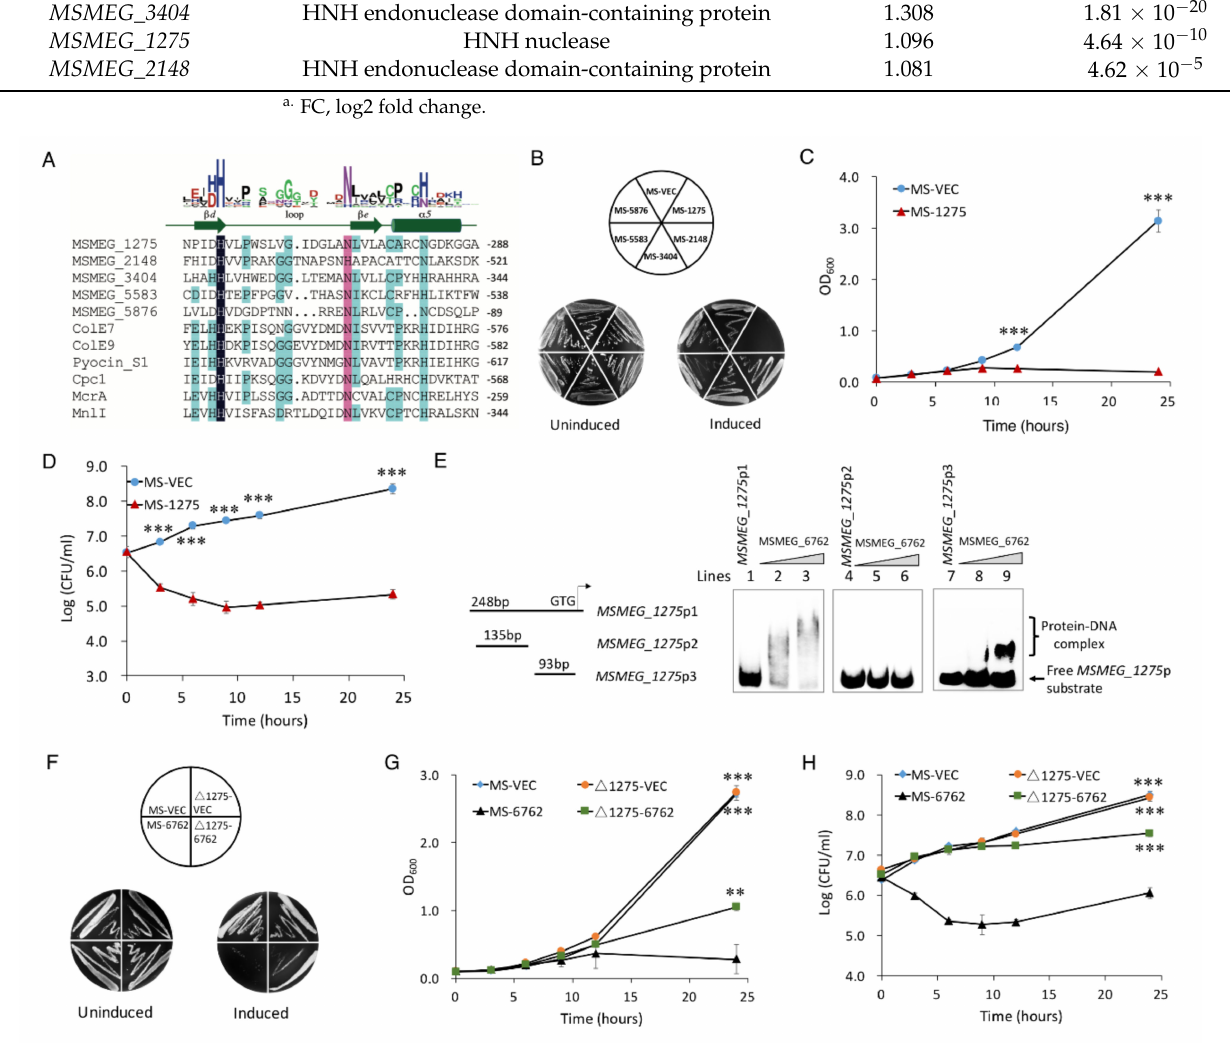
mediated cell death in liquid culture medium. Experiments were performed in triplicate. Data determined using a Student’s t test: ** p < 0.01 and *** p <